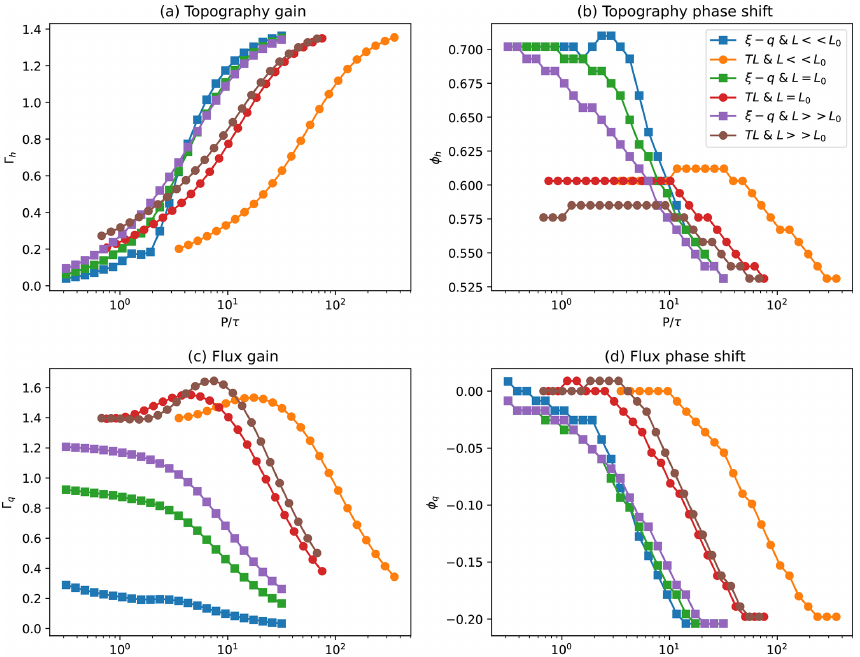
Figure 13. Computed (a) gain and (b) phase shift of the response of the system shape as a function of the period of the imposed periodic precipitation rate normalized by the system’s response time for constrained ( L < L 0 ), intermediary ( L = L 0 ), and open ( L > L 0 ) systems using the ξ – q and TL models. Computed (c) gain and (d) phase shift of the outgoing sedimentary